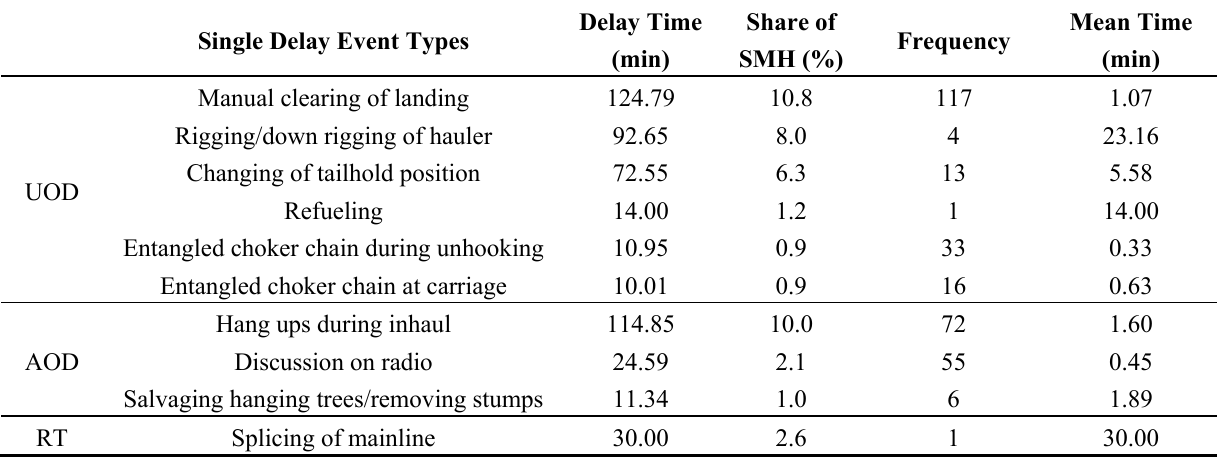
Table 7. Ten main contributing single delay event types sorted according associated delay category, total delay time, share of observed SMH, frequency during the study and mean time per single delay event.